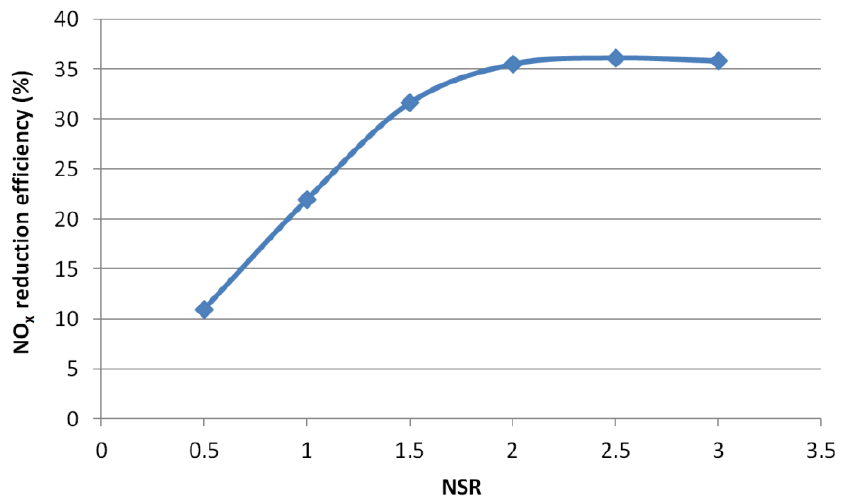
Figure 12. Dependence of NOx reduction on NSR.